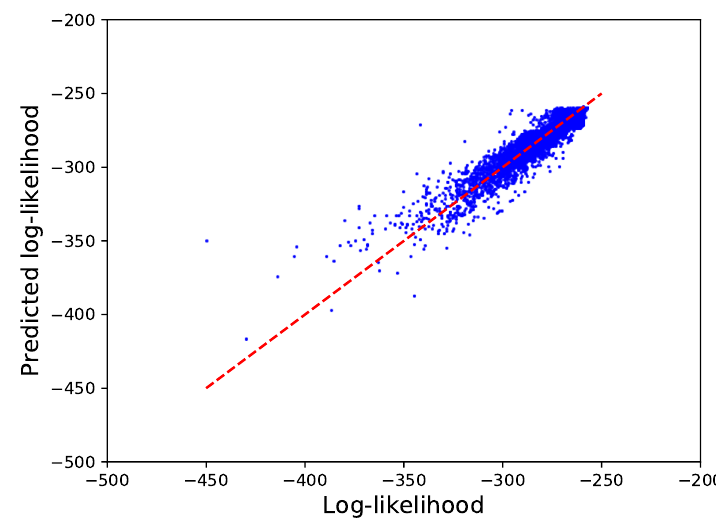
Figure 3. Validation plot of the trained network, showing the true log likelihood on the x -axis and the predicted value on the y